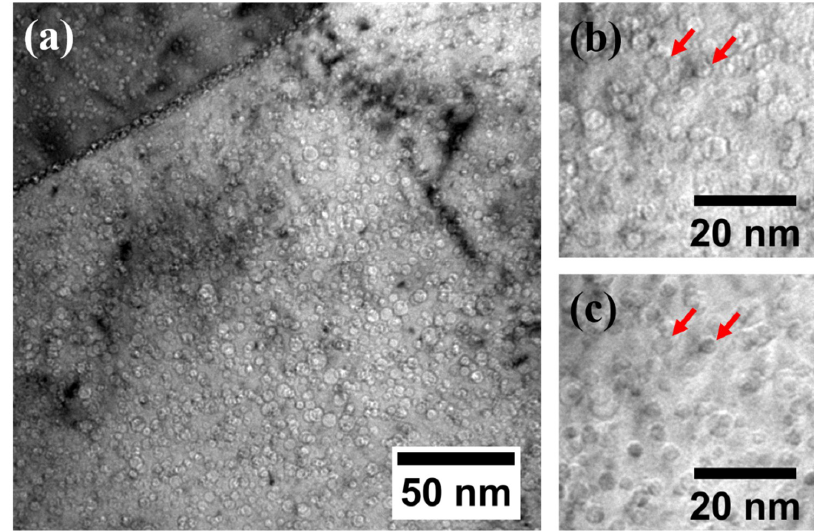
Figure 7. ( a ) Bright-field TEM micrograph, ( b ) under-focused image, and ( c ) over-focused image from the 300–500 nm depth region of the 1 × 10 16 He preimplanted and Fe irradiated specimen.